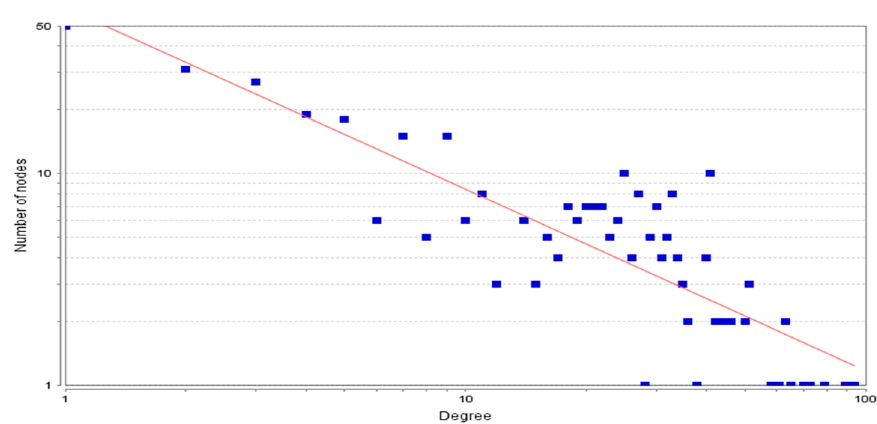
Figure 5. Node degree distribution following power law fitting y = 61,323x − 0.861 (R-squared 0.722).